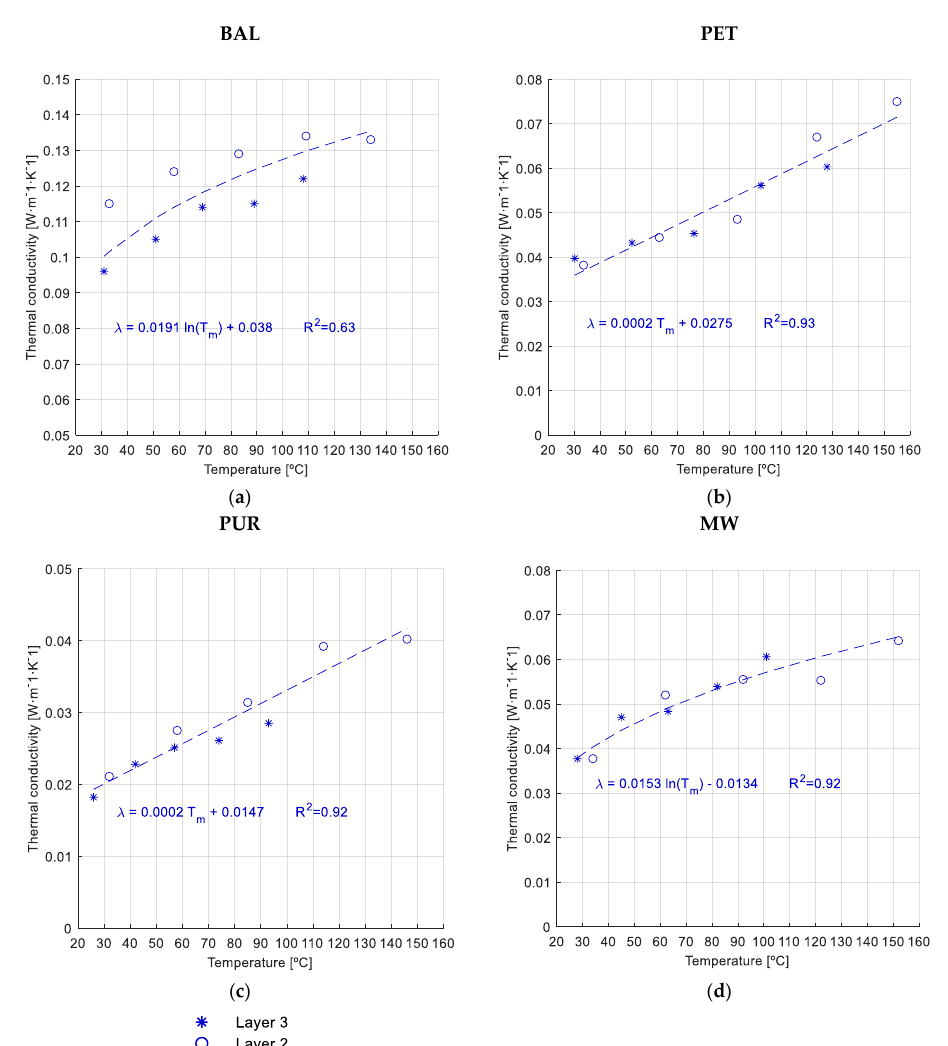
Figure 10. Thermal conductivity/layer temperature (mean values): ( a ) BAL panels; ( b ) PET panels; ( c ) PUR panels; ( d ) MW panels.